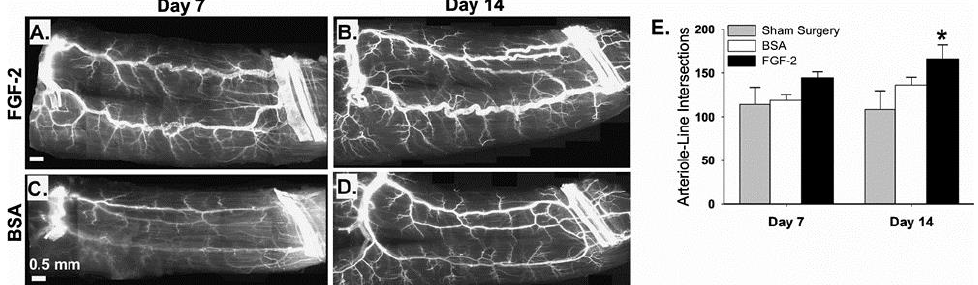
Figure 5. The delivery of FGF-2 bearing nanoparticles by ultrasonic microbubble destruction elicits arteriogenic remodeling in gracilis adductor muscle. ( A – D ) Representative whole-mount images of fluorescently-labeled SM α-actin+ vessels in gracilis adductor muscles seven and 14 days after FGF-2 ( A , B ) and bovine serum albumin (BSA) ( C , D ) treatment. Note the significant increase in arteriolar caliber and density in FGF-2-treated muscles. ( E ) Bar graph of arteriole-line intersections at both time points for FGF-2, BSA, and sham surgery treatment. Values are means with standard errors. * Indicates significantly different ( p < 0.05) to BSA and sham surgery at day 14. Adapted from Chappell et al. [114].